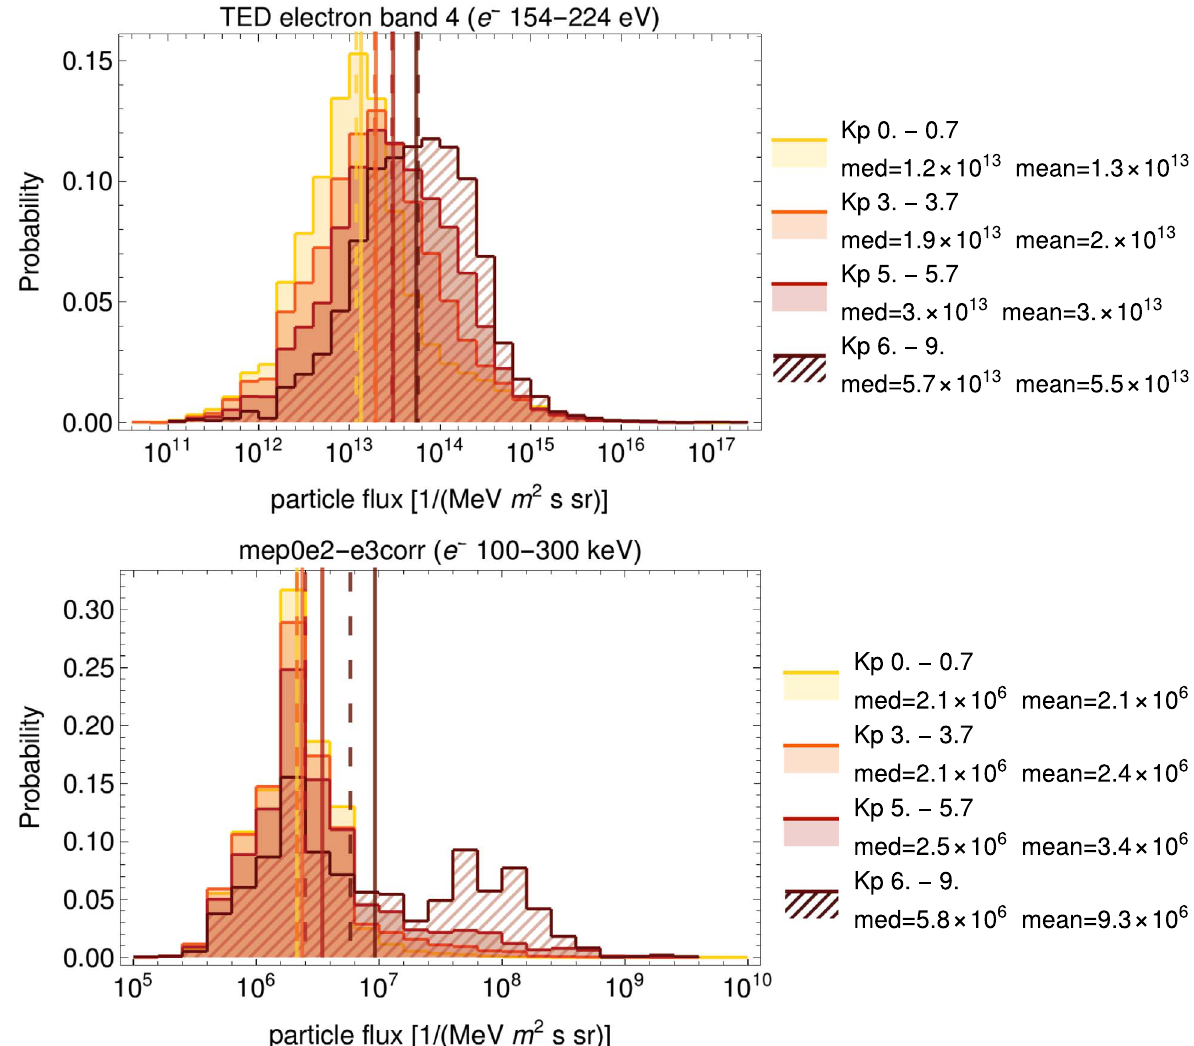
Figure 2. The fi gure shows typical fl ux distributions in the central polar cap ( (cid:5) 86 (cid:1) north and south) for selected Kp levels. The lowest electron channel is presented in upper panel, the highest electron channel is given in the lower panel. The dashed lines are the corresponding medians and the solid lines are the